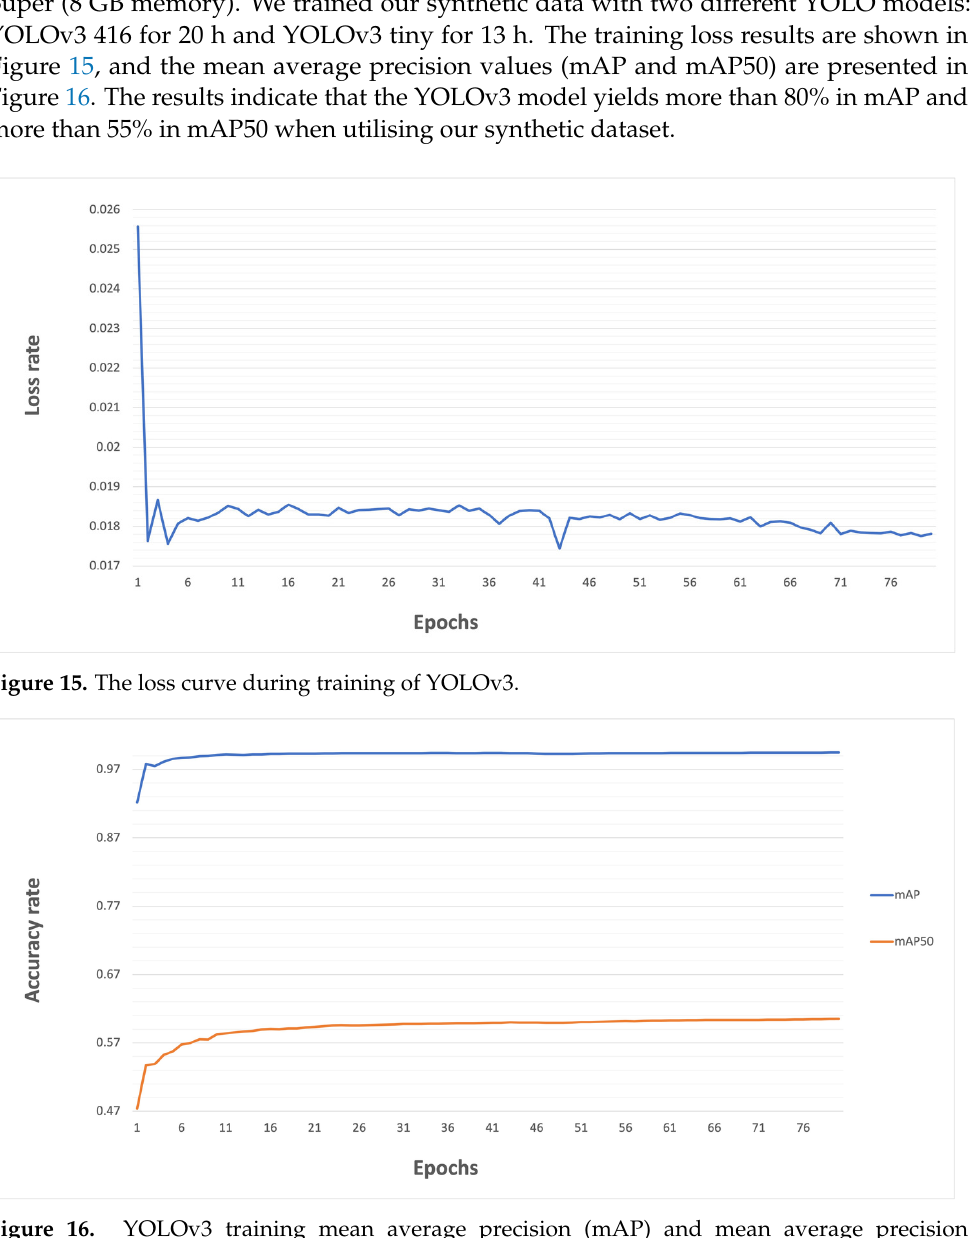
Figure 16. YOLOv3 training mean average precision (mAP) and mean average precision 50 (mAP50)